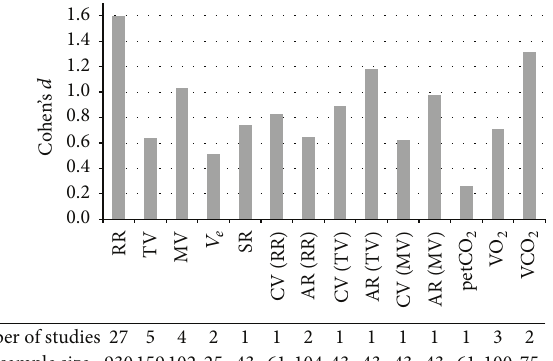
Figure 1: Sample weighted means of Cohen’s 𝑑 for each respira- tory parameter considering all studies that provided the required descriptives to compute standardized mean differences. The respec- tivenumberofstudiesaswellastotalsamplesizeandaveragesample size are displayed in the column below each parameter (RR: respira- tory rate; TV: tidal volume; MV: minute ventilation; 𝑉 𝑒 : expiratory volume; SR: sigh rate; CV: coefficient of variation; AR: autocorre- lation; petCO 2 : partial pressure of end-tidal carbon dioxide; VO 2 : oxygen consumption; VCO 2 : carbon dioxide